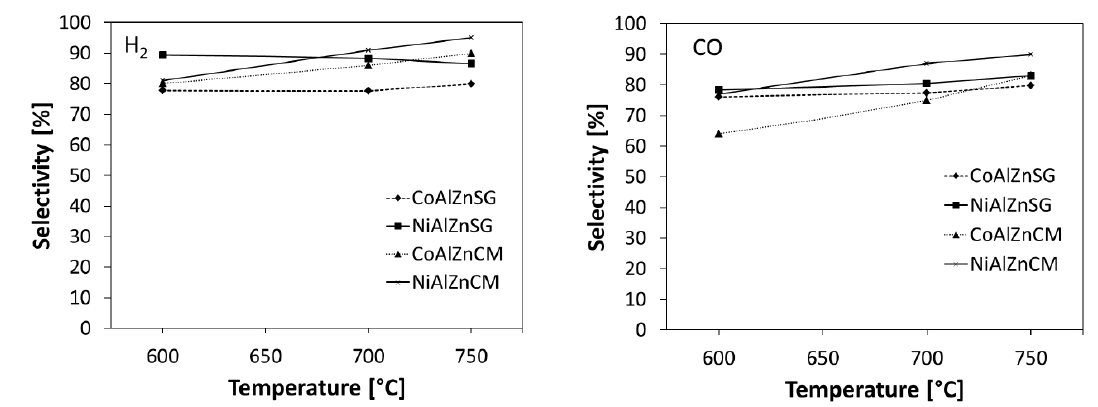
Figure 5. Selectivity of ethanol partial oxidation to hydrogen and CO, respectively, on different catalysts (molar ratio O